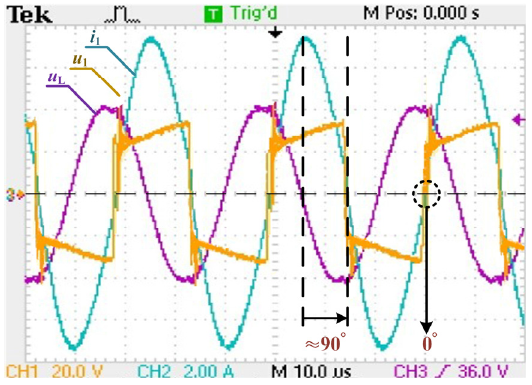
Figure 9. The phase relationship between voltage and current.